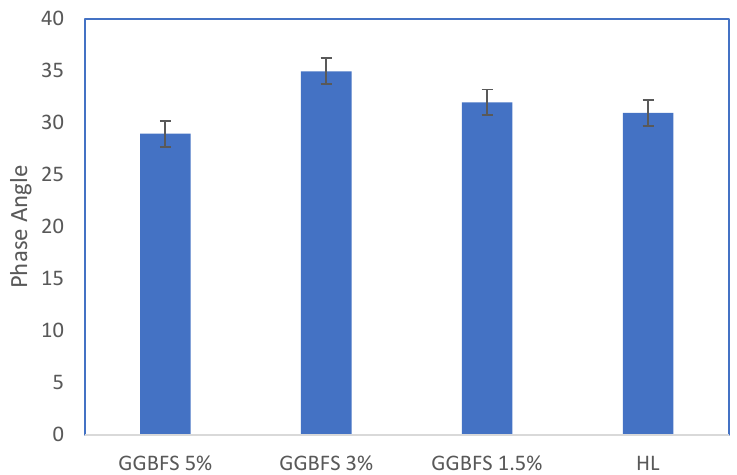
Figure 9. Phase angles of different asphalt mixtures.